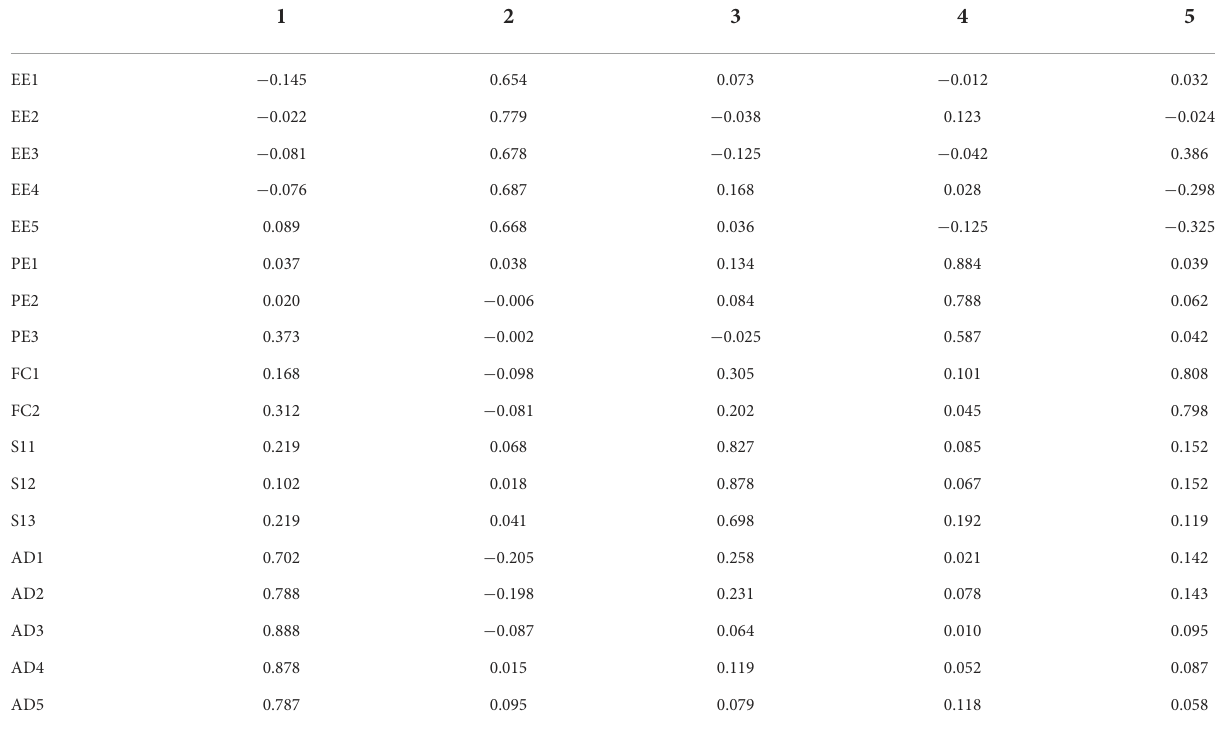
TABLE 2 Results of exploratory factor analysis.